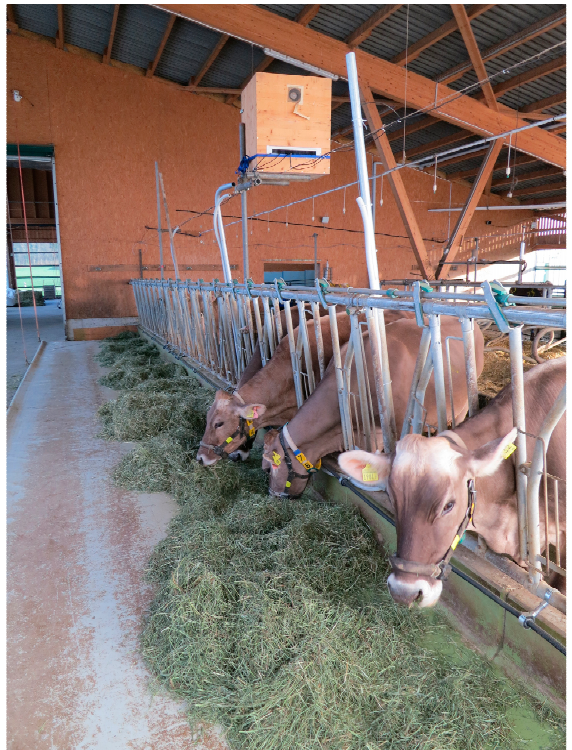
Figure 5. Installation of the three cable antennas along the feed fence.